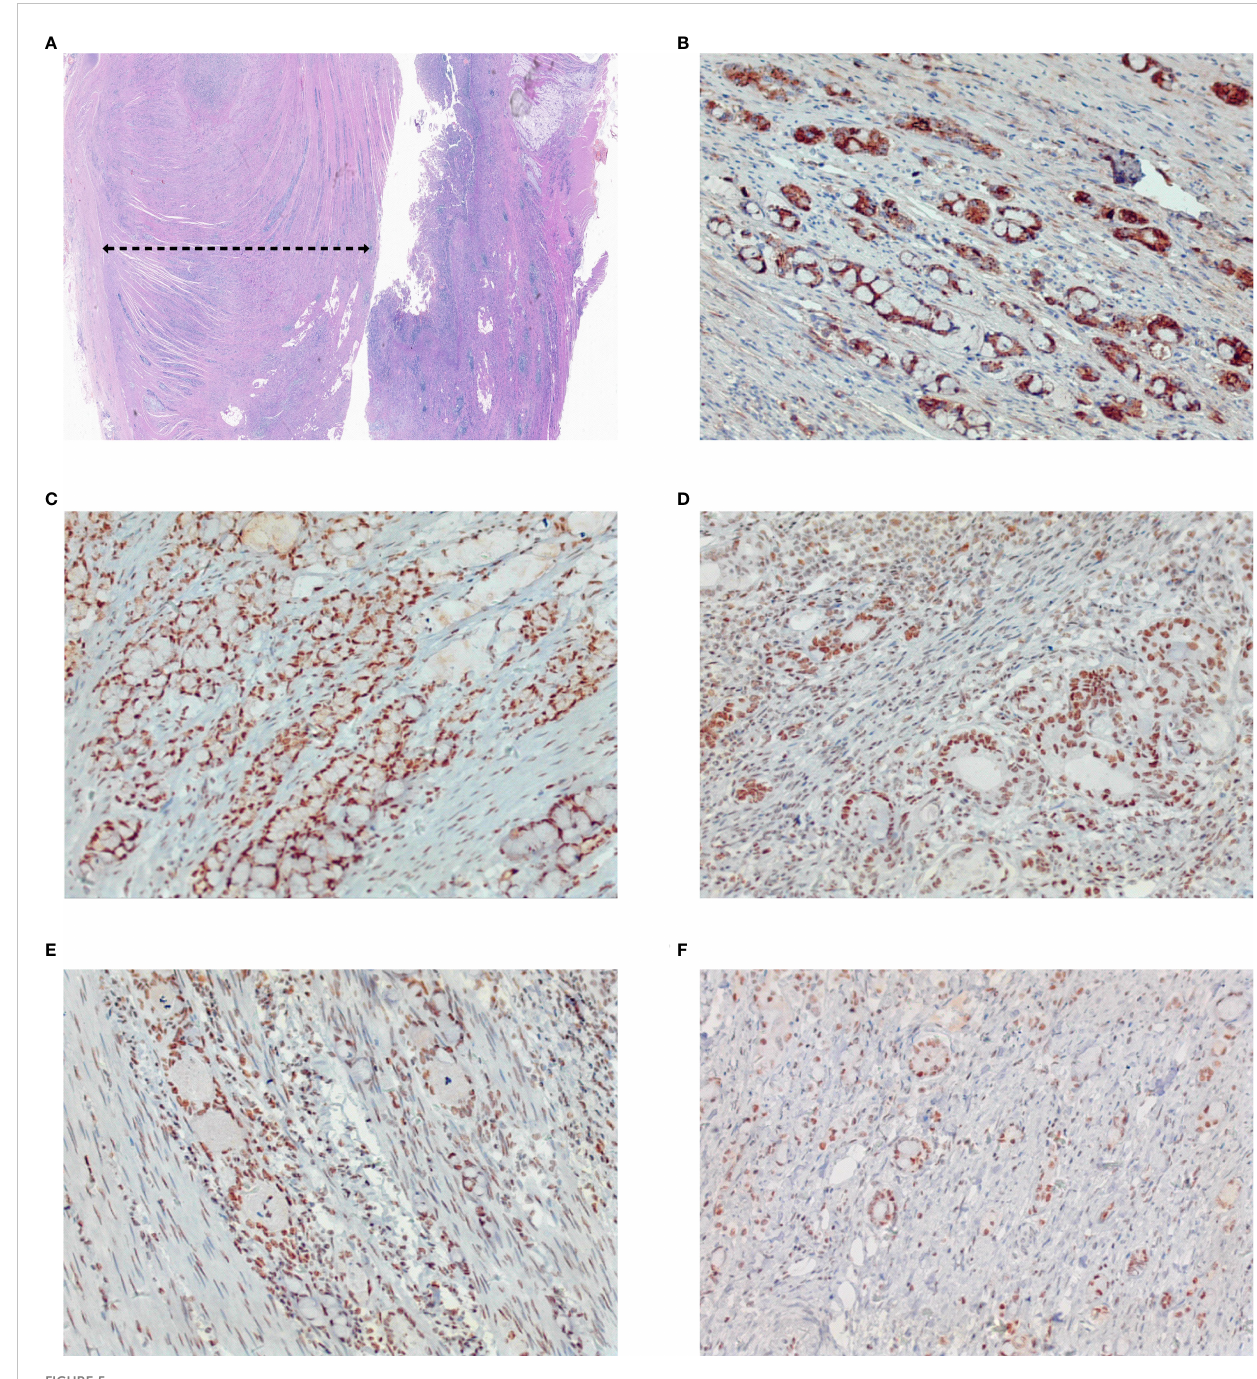
FIGURE 5 Pathological aggressiveness and microsatellite instability of the tumor. The tumor occupies about 80% of the whole tumor (A) . Immunohistochemistry staining showed E-Cadherin (+) (B) , MLH1 (+) (C) , MSH2 (+) (D) , MSH6 (+) (E) , and PMS2 (+) (F) , which indicates it is microsatellite instability-low (MSI-L) cancer. Original magni fi cation ×4 for (A) , and magni fi cation ×200 for (B – F)